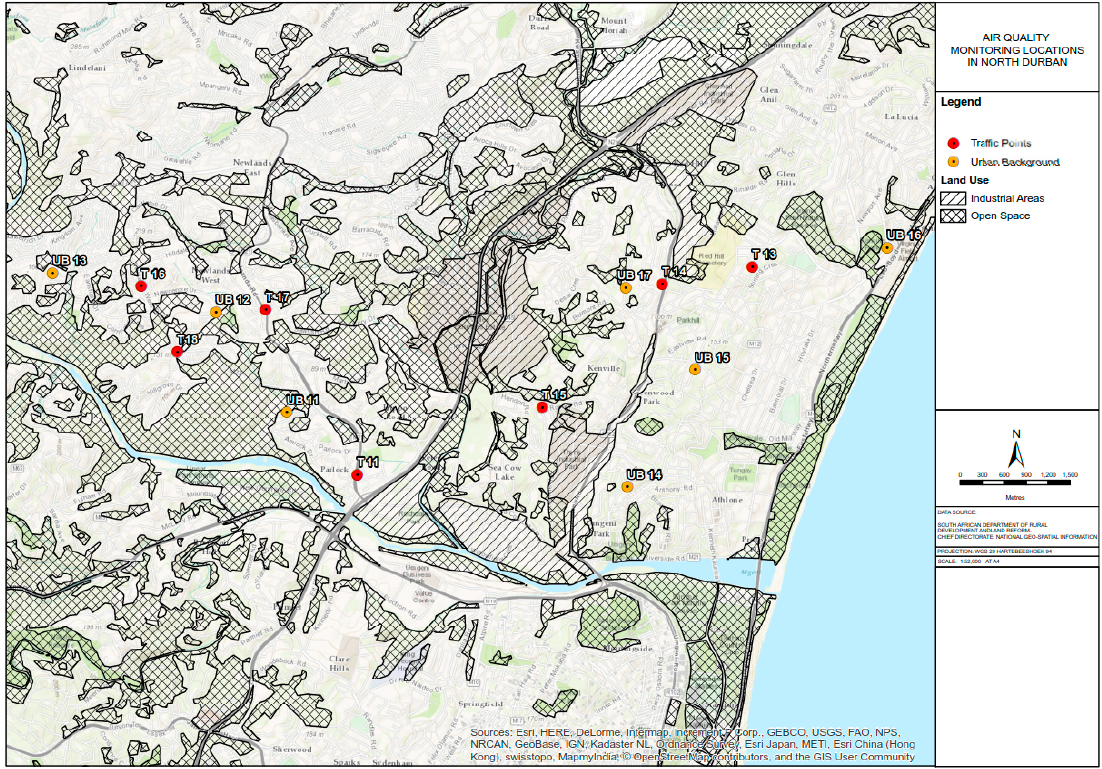
Figure 4. Location of air quality monitoring samplers in north Durban.